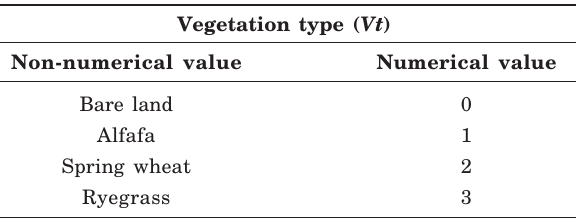
Table 1. Quantification of the non-numerical vegetation type ( Vt )